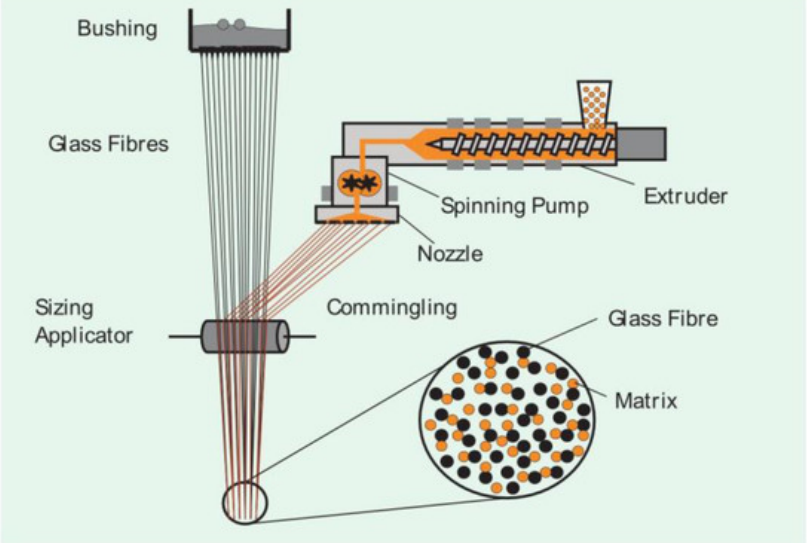
Figure 17. Processing scheme for commingled yarn. Reprinted from Reference [63] under Creative Commons license.